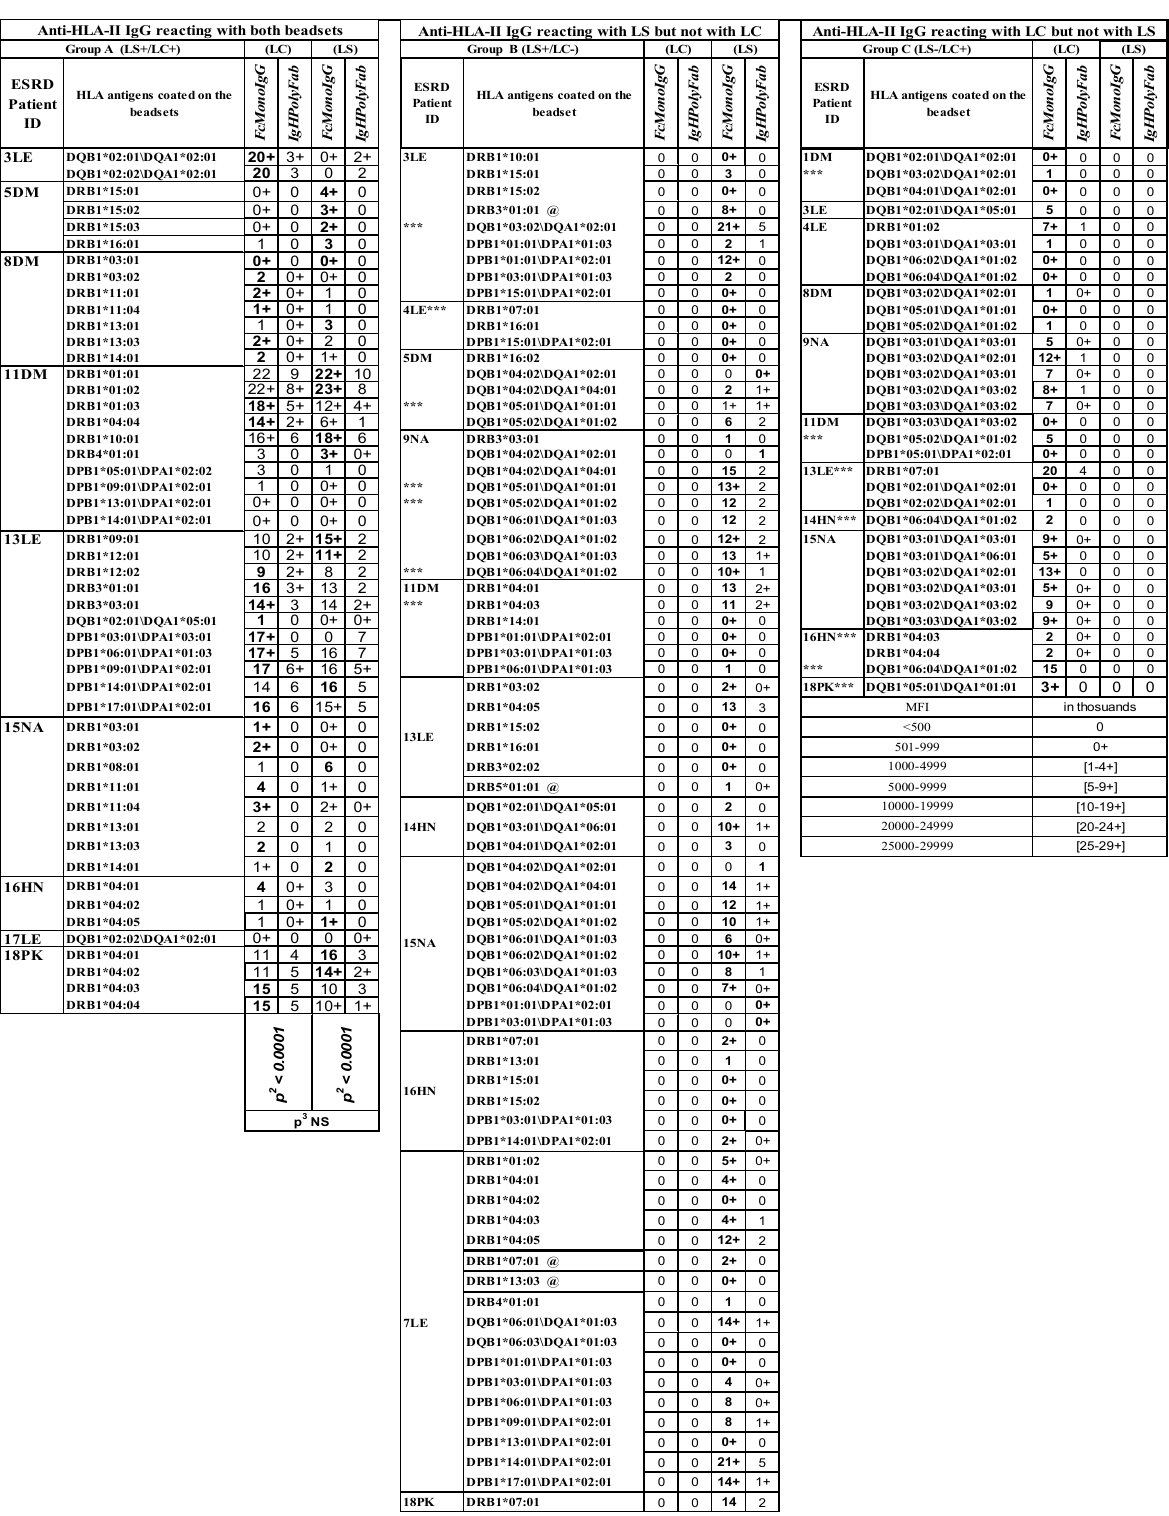
Figure 3. Three groups of serum IgG antibodies in ESRD patients reacting to HLA-II antigens on either LS or LC, or to both SABs, when tested with two different detection Abs ( FcMonoIgG and IgHPolyFab ). MFI values are expressed as thousands. Group A: Abs binding to both SABs; Group B: Abs binding to LS-SAB only; Group C: Abs binding to LC-SAB only. IgG antibodies recognizing antigens unique to the SABs are excluded. Sera of patients 2DM, 6FG, 10DM, 12DM, 19HN and 20 HN showed no anti-HLA-II Ab reactivity. The sera were tested at 1/10 dilution and the cut-off of the normalized/trimmed mean MFI is 500. HLA antigen with @ sign refer to patient’s self-antigen recognized by the patient’s